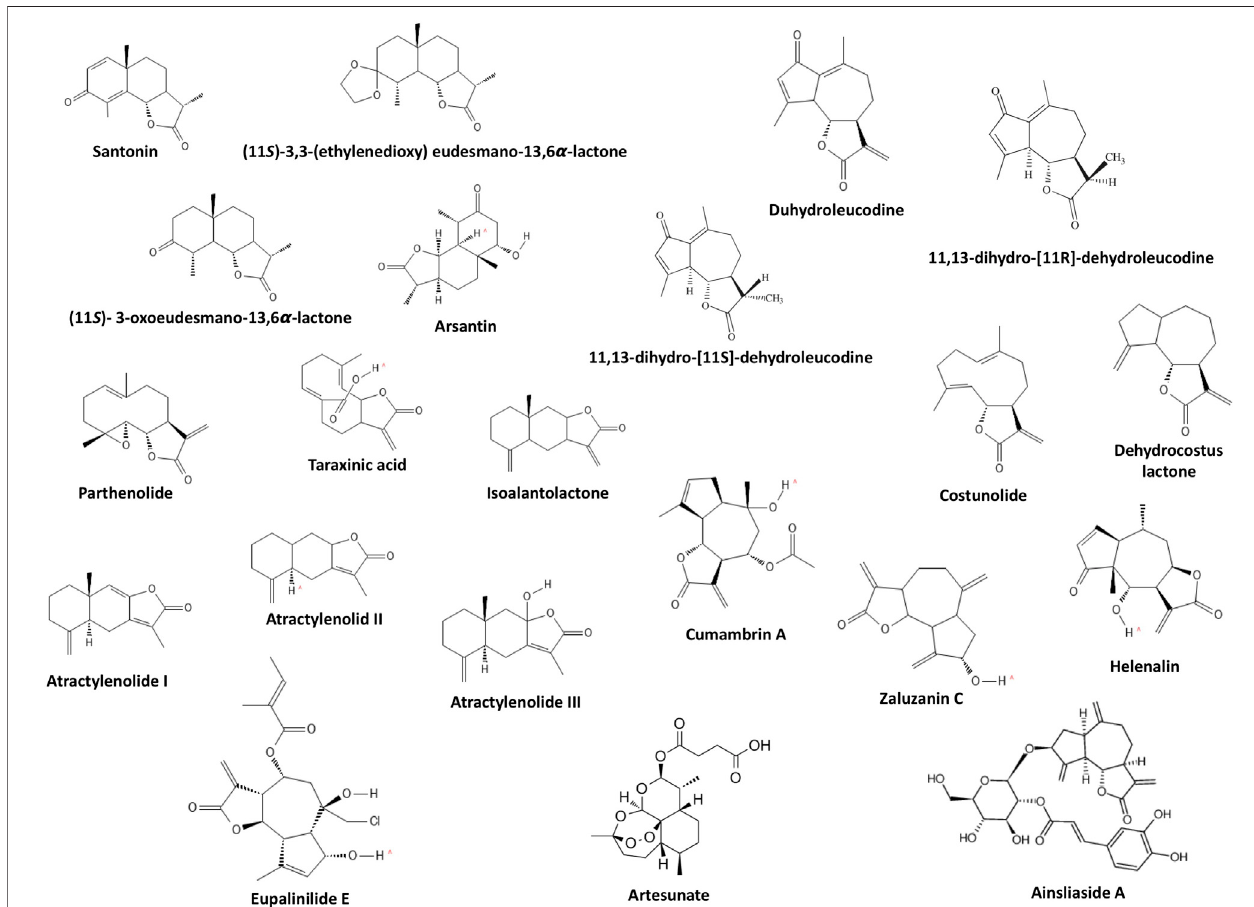
FIGURE 4 | Chemical structure of evaluated sesquiterpene